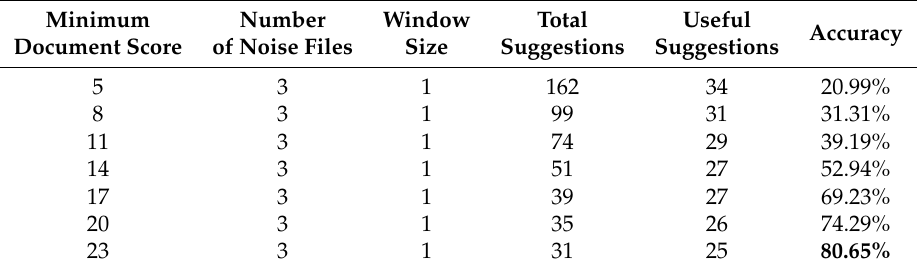
Table 5. Neighbourhood approach – minimum document score impact.